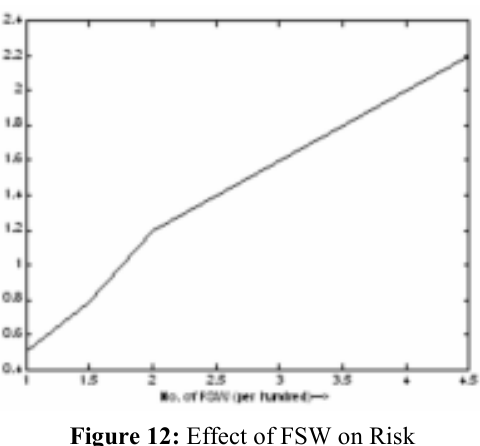
Figure 12: Effect of FSW on Risk